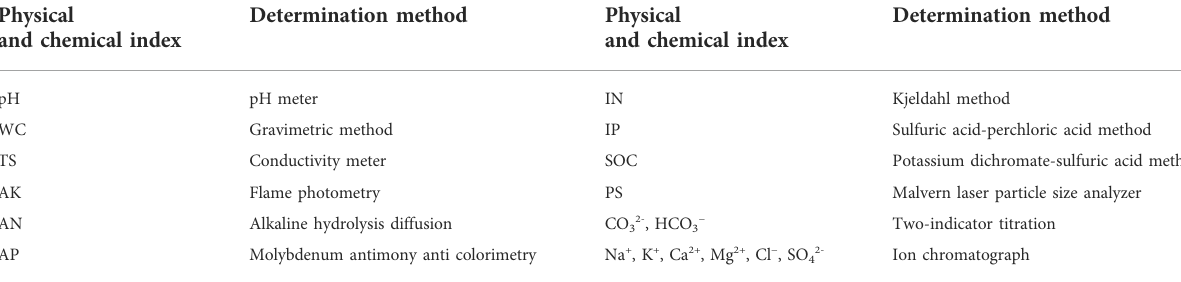
TABLE 1 Determination methods of physical and chemical indexes of soil. Physical and chemical